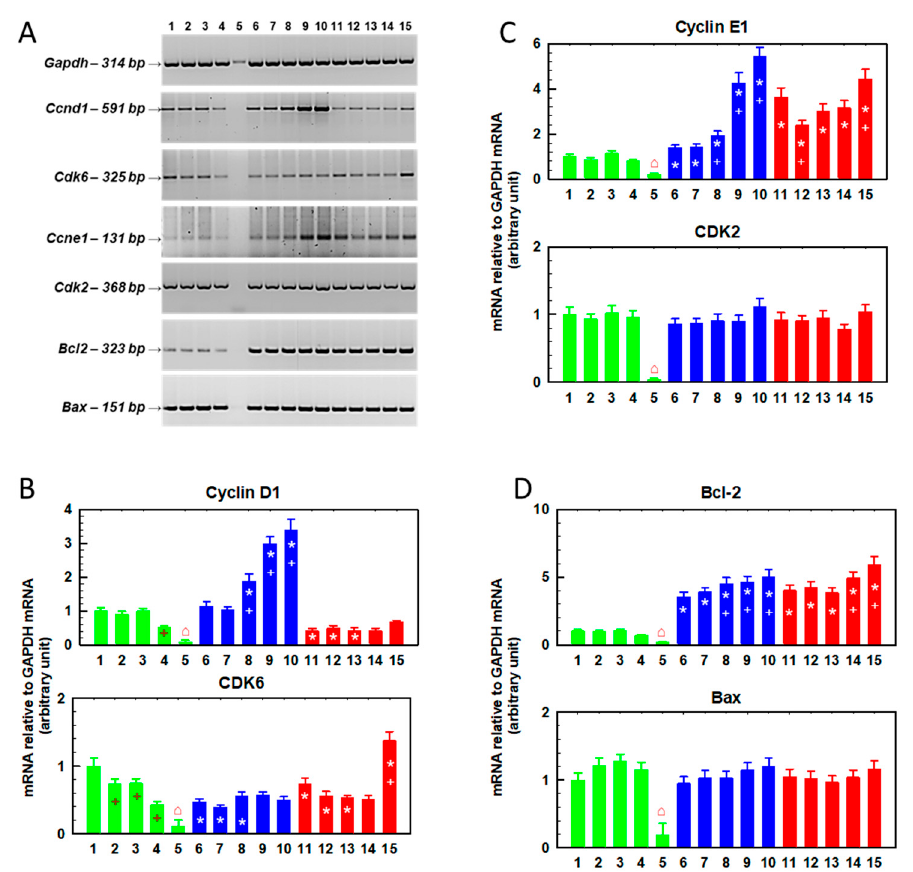
Figure 5. Changes in the relative gene expression of Ccnd1 (for cyclin D1), Cdk6 (for cyclin-dependent kinase 6), Ccne1 (for cyclin E1), Cdk2 (for cyclin-dependent kinase 2), Bcl2 and Bax in S, R and T cells passaged six times in SFN-containing medium. At each passage, cells were cultured for 48 h in the presence of SFN at the following concentrations: (1) 0.0 μ M S cells, (2) 2.5 μ M S cells, (3) 5.0 μ M S cells, (4) 7.5 μ M S cells, (5) 10.0 μ M S cells, (6) 0.0 μ M R cells, (7) 2.5 μ M R cells, (8) 5.0 μ M R cells, (9) 7.5 μ M R cells, (10) 10.0 μ M R cells, (11) 0.0 μ M T cells, (12) 2.5 μ M T cells, (13) 5.0 μ M T cells, (14) 7.5 μ M T cells and (15) 10.0 μ M T cells. ( Panel A ) Electrophoretic analysis of the respective PCR products. The GAPDH gene was used as an internal control. Data are representative of three independent measurements. The number of S cells after six passages in the presence of SFN at a concentration of 10 μ M was significantly reduced, and after isolation of total RNA, we did not obtain enough quality polyribonucleic acid for GAPDH and other genes detection ( ⌂ ). ( Panels B – D ) The optical densities of the PCR product bands were quantified and are summarized in bar plots. The data are expressed as the mean ± SD of three independent measurements. S cells (green), R cells (blue) and T cells (red). Significance * means that the data differ from corresponding obtained for S cells at the level p < 0.02; + means that the data differ from corresponding conditions observed for cells in the absence of SFN p < 0.02.